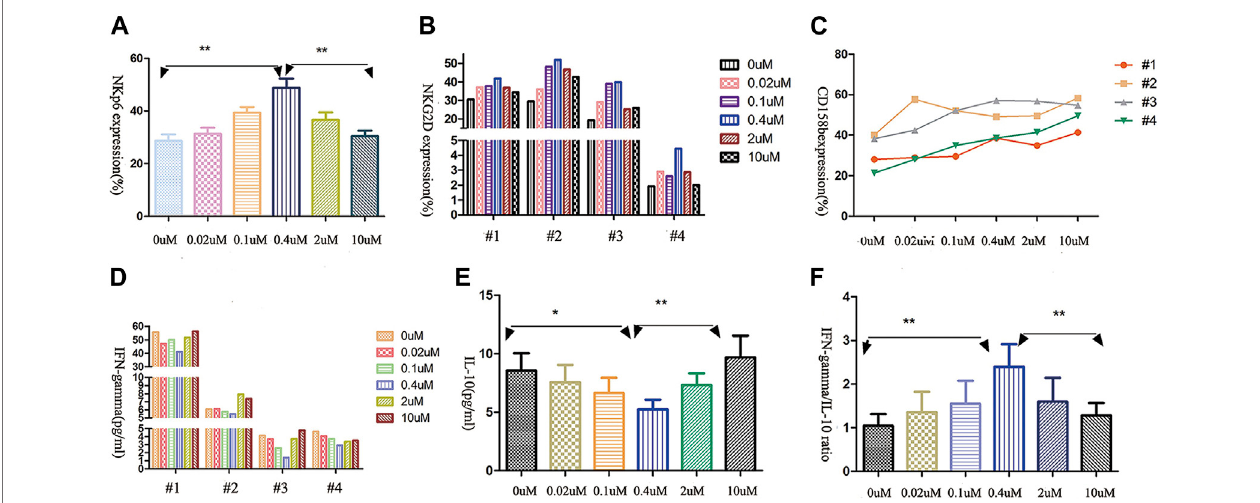
FIGURE3| TheeffectsofdecitabineexposureonprimaryNKcellsreceptorexpressionandcytokinerelease. (A,B) TheexpressionofNKcells-activatingreceptors NKG2D and NKp46 showed parabola-shaped concentration-dependent response to decitabine exposure ( n (cid:2) 4; p (cid:2) 0.0038). (C) The expression of inhibitory receptor CD158a increased with the increasing concentrations of decitabine (D,E) The release of IFN- γ and IL-10 both had U-shaped concentration-dependent responses, with nadirs at 0.4 μ mol/L treatment group. (F) The ratio of IFN- γ to IL-10 showed parabolic response, peak value at 0.4 μ mol/L treatment groups ( n (cid:2) 4, p (cid:2) 0.0034).